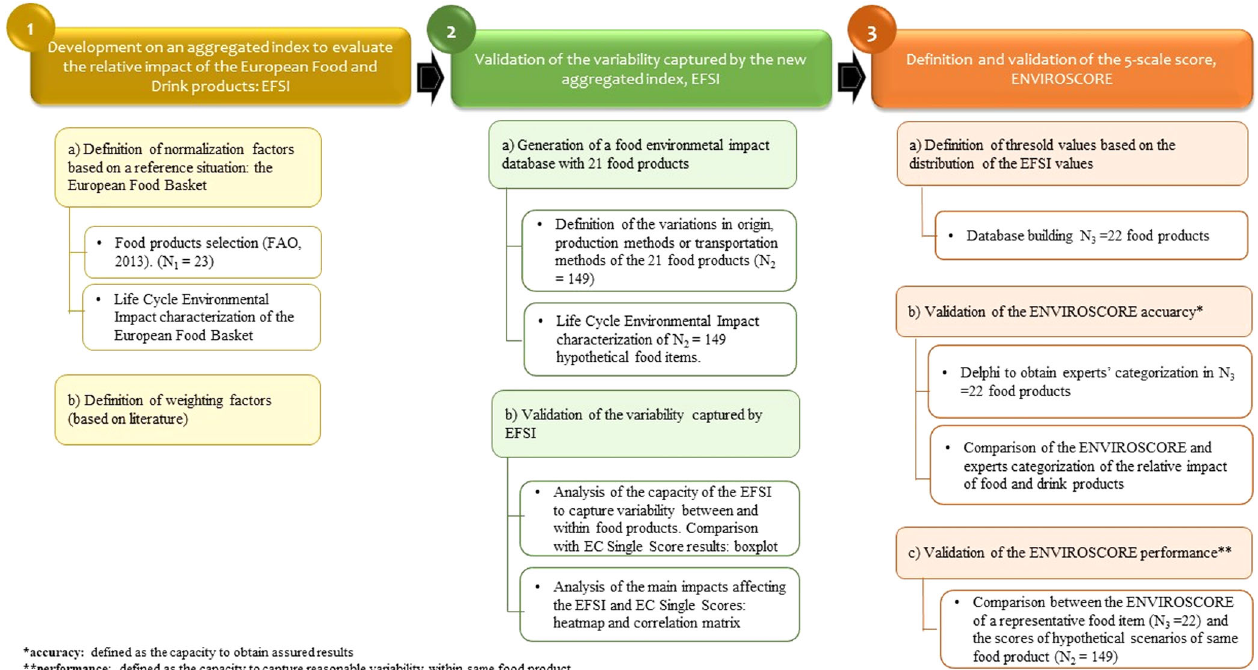
Fig. 5 Scheme representing the main steps of the methodology followed to develop and validate the Enviroscore. First, the development on an aggregated index to evaluate the relative impact of the European Food and Drink products (EFSI) was created. As a second step, the variability capture by EFSI was validated. Finally, the Enviroscore was de fi ned as a 5-scale